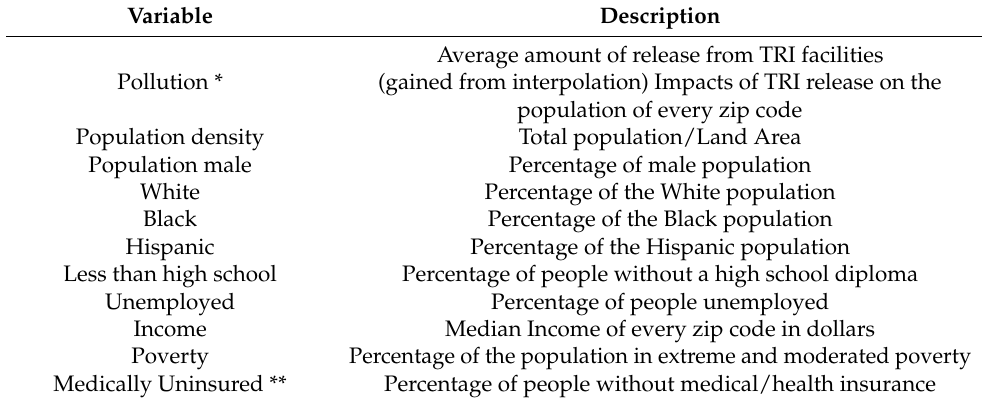
Table 1. Independent